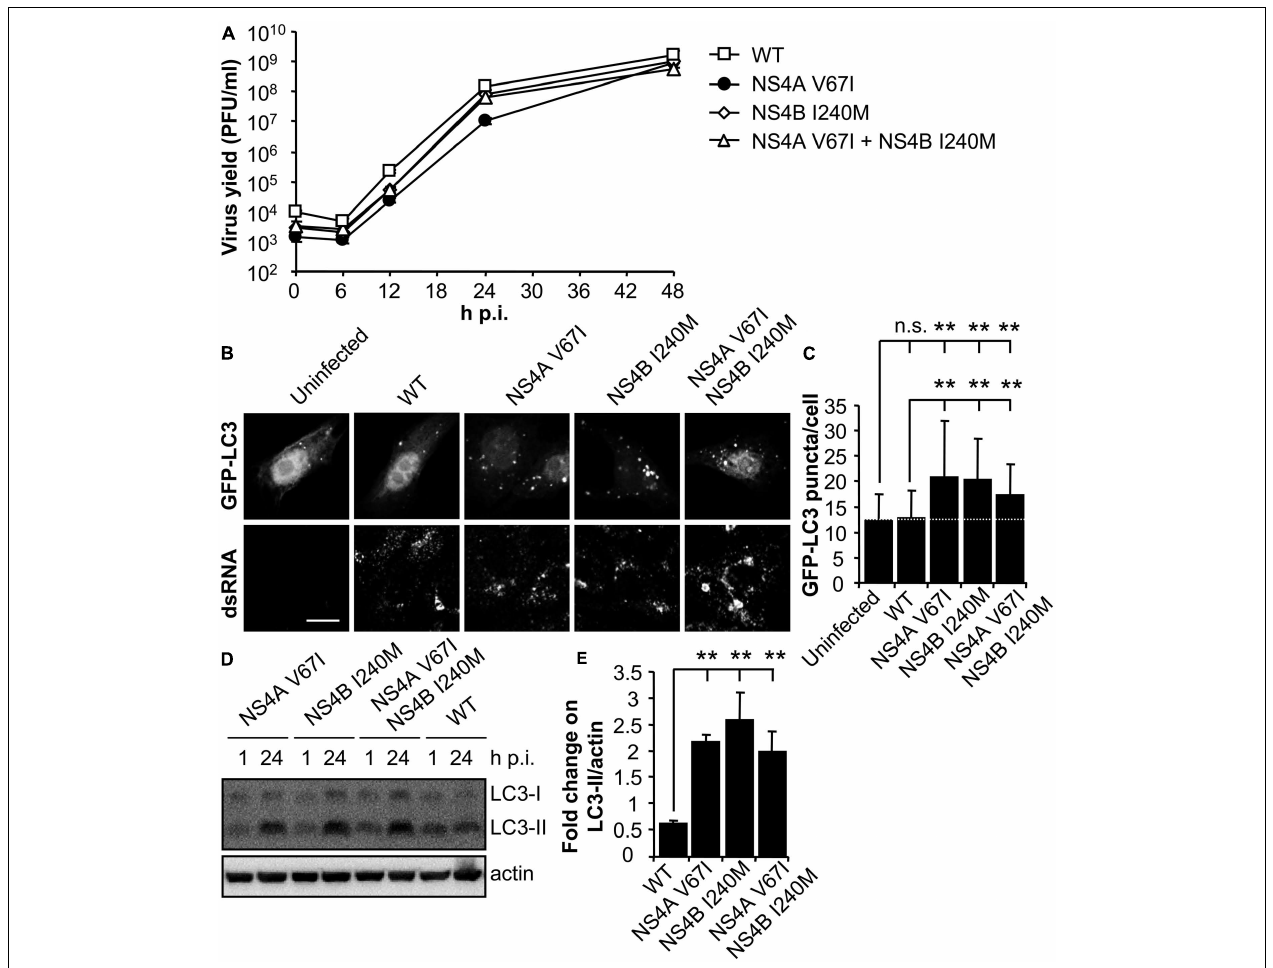
FIGURE 3 | Mutations on WNV NS4A or NS4B can modulate the induction of LC3 modification and aggregation in cells infected with WNV. (A) Growth curves of recombinant WNV recovered from infectious cDNA clone pFLWNV (WT) or its derivatives carrying amino acid substitutions NS4A V67I, NS4B I240M or NS4A V67I + NS4B I240M. Vero cells were infected (MOI of 0.5 PFU/cell) with the viruses and the supernatant virus yield was determined at different times p.i. (B) Visualization of autophagosome formation by LC3 aggregation in cells infected with the viruses displayed in panel (A) . Vero cells were transfected with a plasmid encoding GFP-LC3 and 24 h post-transfection were infected (MOI of 5 PFU/cell), fixed and processed for immunofluorescence analysis as described in the legend for Figure 1 .